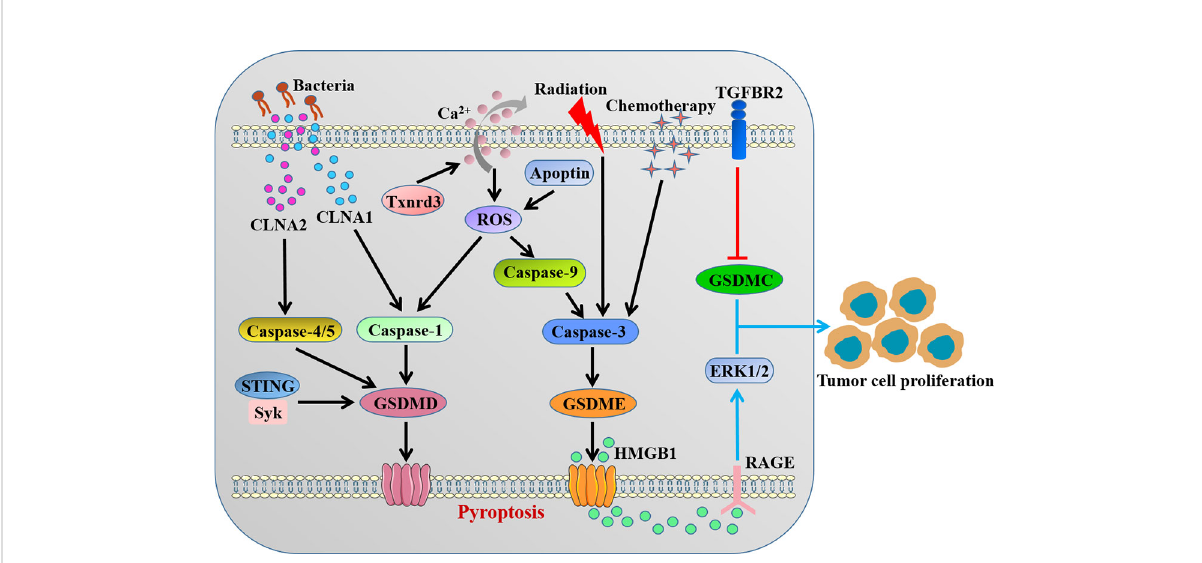
FIGURE 3 The contradictory role of GSDMs in colorectal cancer. CLNAs from probiotic bacterium and intracellular calcium out fl ow-caused ROS activate caspase-1/4/5 to cleave GSDMD. STING-mediated Syk signaling induces GSDMD-driven pyroptosis. Apoptin/ROS/caspase-9 axis, radiation and chemotherapy activate caspase-3 to cleave GSDME. The cleavage of GSDMD or GSDME inhibits the occurrence and progression of tumors by inducing pyroptosis. GSDMC and GSDME-related HMGB1 release promote tumor cell proliferation. CLNA, conjugated linolenic acid; Txnrd3, thioredoxin reductase 3; ROS, reactive oxygen